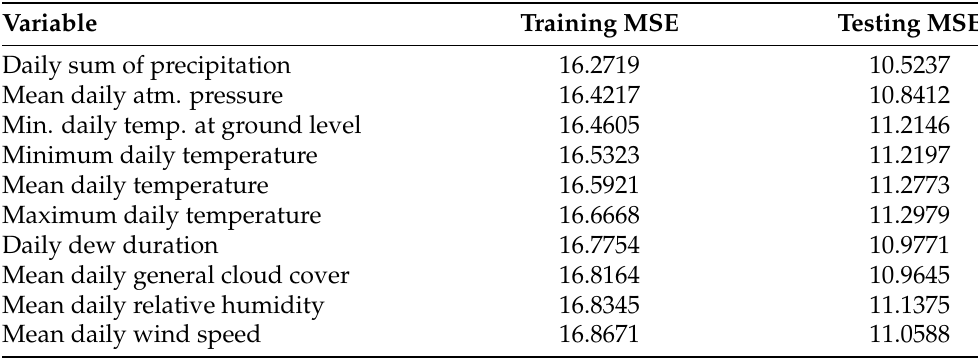
Mean daily atm. pressure